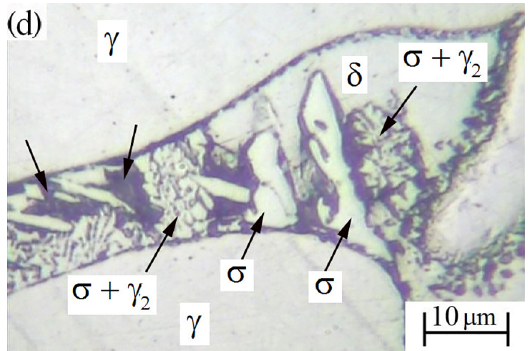
Figure 14. Microstructure obtained after portable DL-EPR test performed at room temperature in SD-B material aged at 850ºC for 45